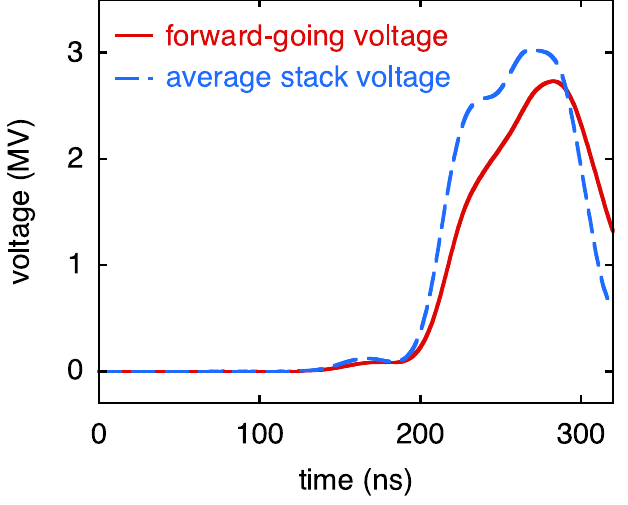
FIG. 5. (Color) Comparison of the average insulator-stack volt- age with the forward-going voltage for the seven shots taken with Z ’s baseline load. If the impedance of each of the four stack-MITL levels were constant and equal to Z Fig. 4), the stack voltage would be identical to the forward-going voltage. The above plot indicates the extent to which the stack voltage is modified by the actual time-dependent impedances of the four stack-MITL